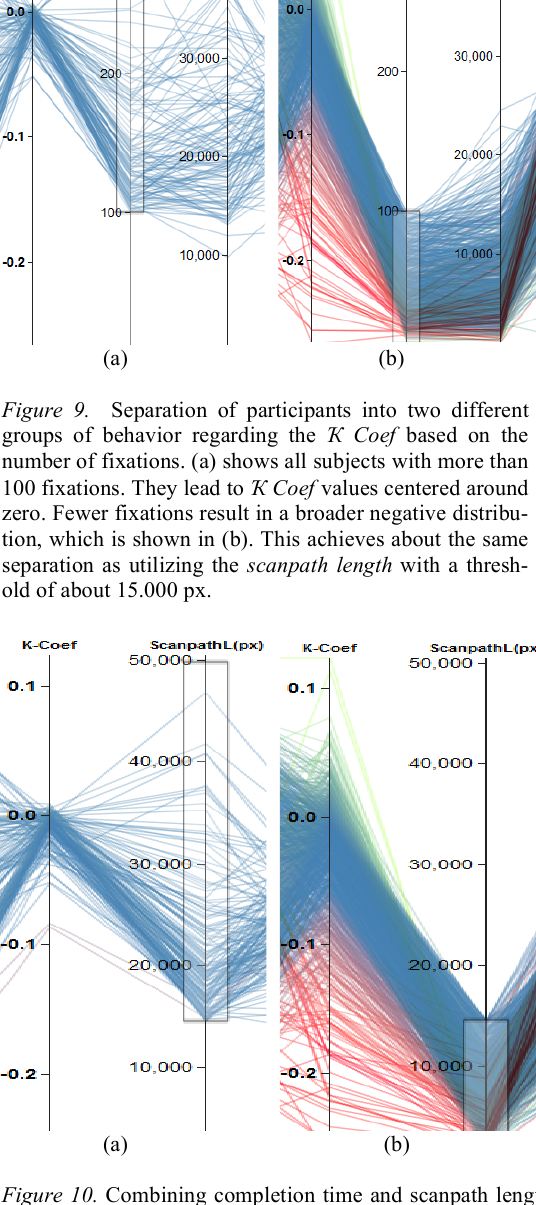
Figure 10. Combining completion time and scanpath length to generate a new 1D metric ( W-Avg ). (a) shows that values above a threshold of 0.3 of W-Avg result in one group of participants that exhibit ambiguous gaze behavior, whereas (b) depicts the second group having a more ambient gaze behavior, according to the Ҡ coefficient.